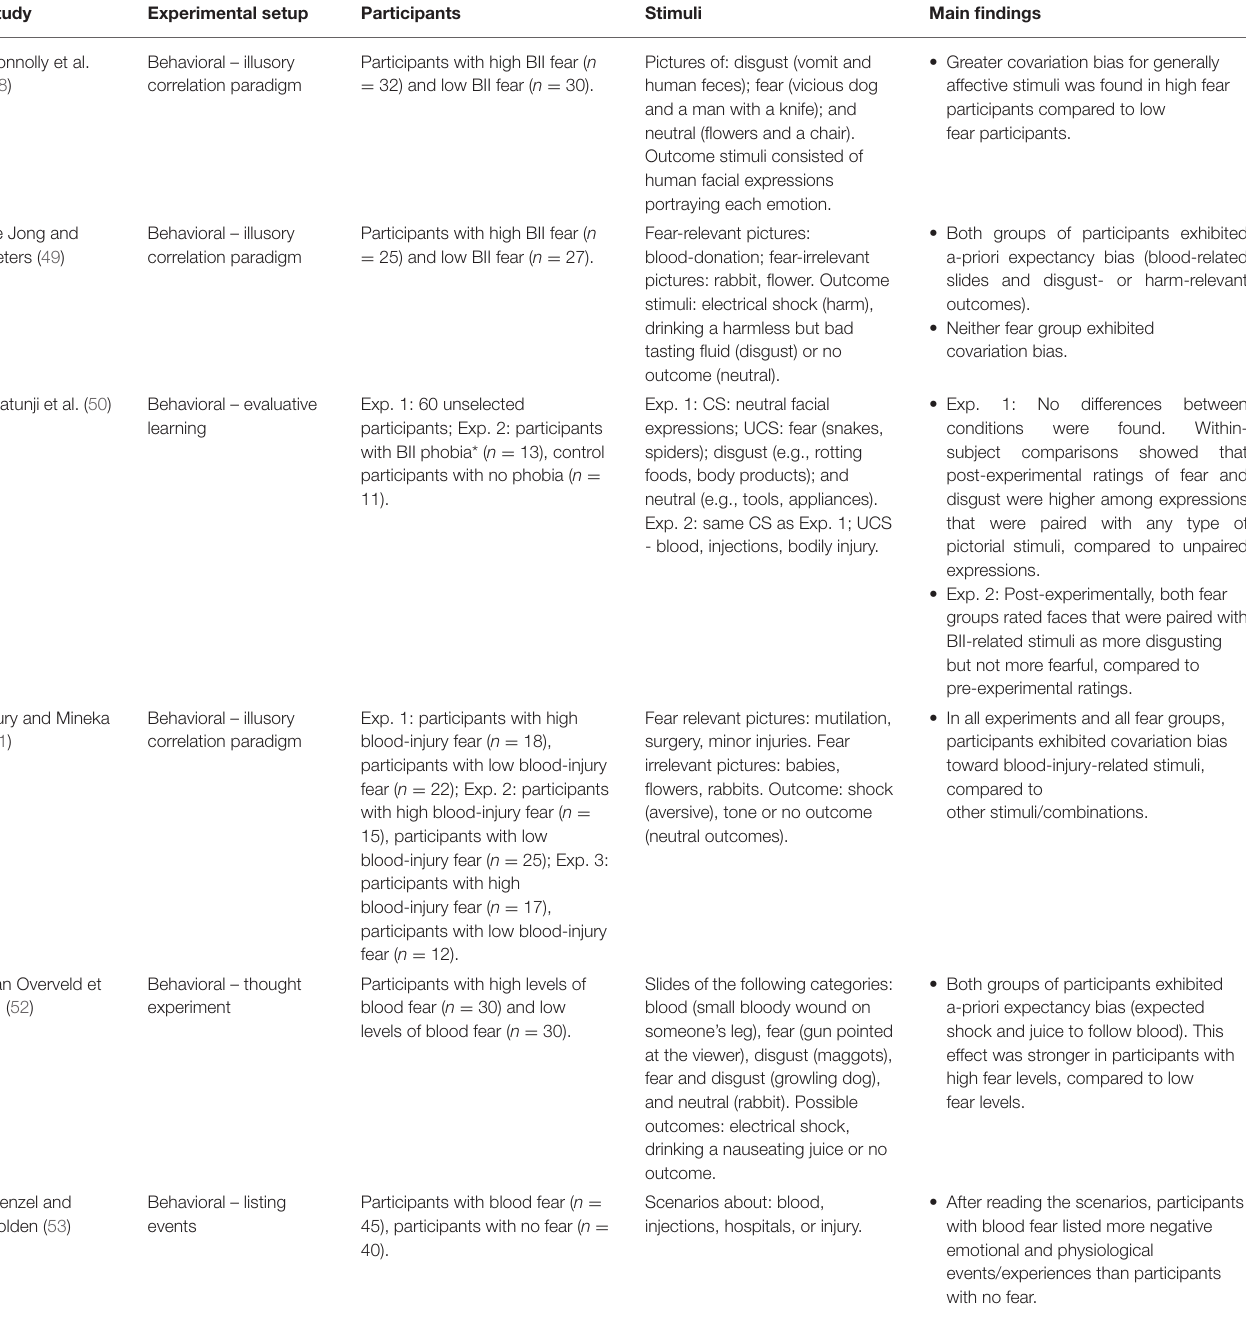
TABLE 2 | Summary of studies on expectancy bias in BII